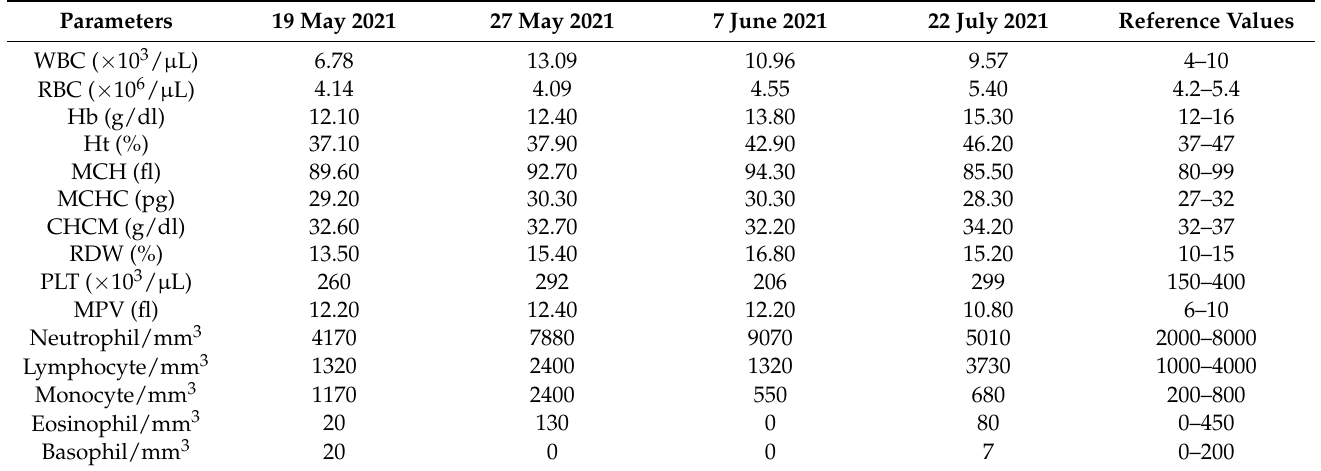
Table 1. Patient’s hemogram test